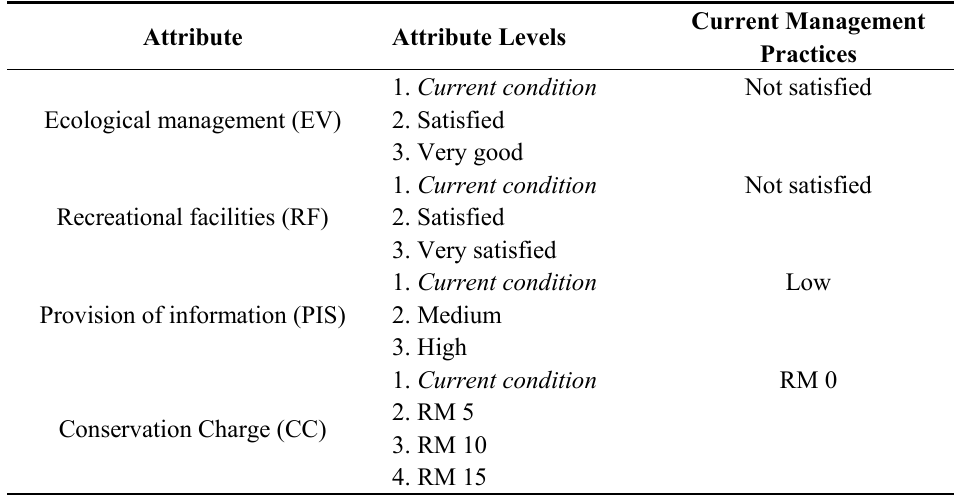
Table 1. Attributes and Levels Selected for